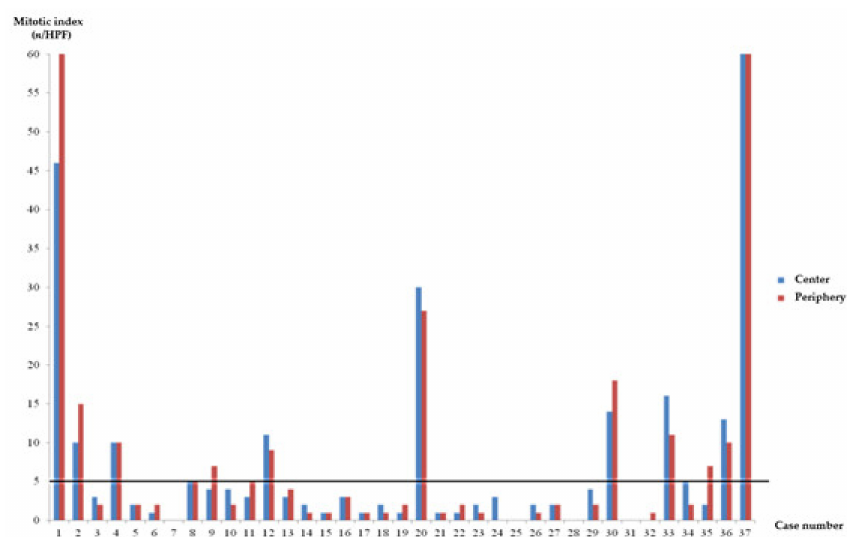
Figure 3. Mitotic index agreement between the center and the periphery. HPF, High-Power